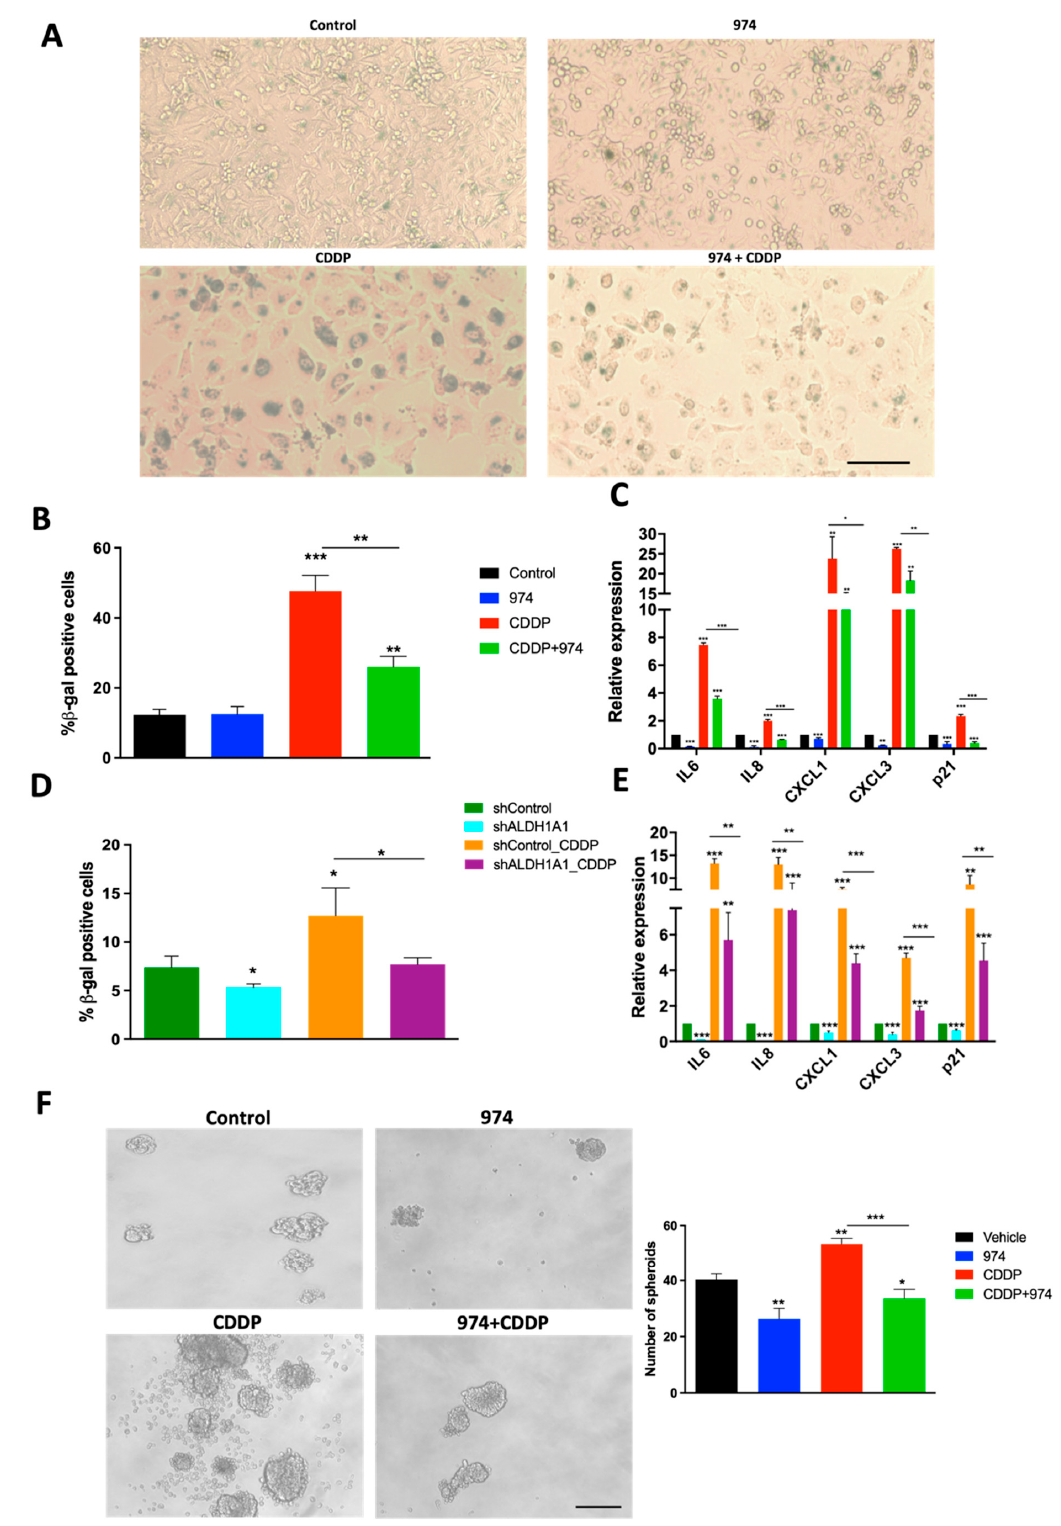
Figure 5. ALDH1A1 inhibition suppresses chemotherapy-induced senescence and stemness in HGSOC cells. ( A ) Senescence-associated (SA) beta-gal assay was performed on OVCAR3 cells treated with DMSO, compound 974 (5 µ M for 48 h), cisplatin (CDDP) (15 µ M for 16 h), or both. Representative images at 10 × magnification. ( B ) Quantification of SA-beta-gal assay represents percentage of senescent cells averaged from five different fields in each condition. ( C ) Expression